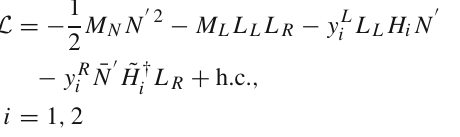
Table 1 Couplings of the Higgses to the SM fermions as a function of the angles α and β and in the alignment limit where (β − α) → π/ 2